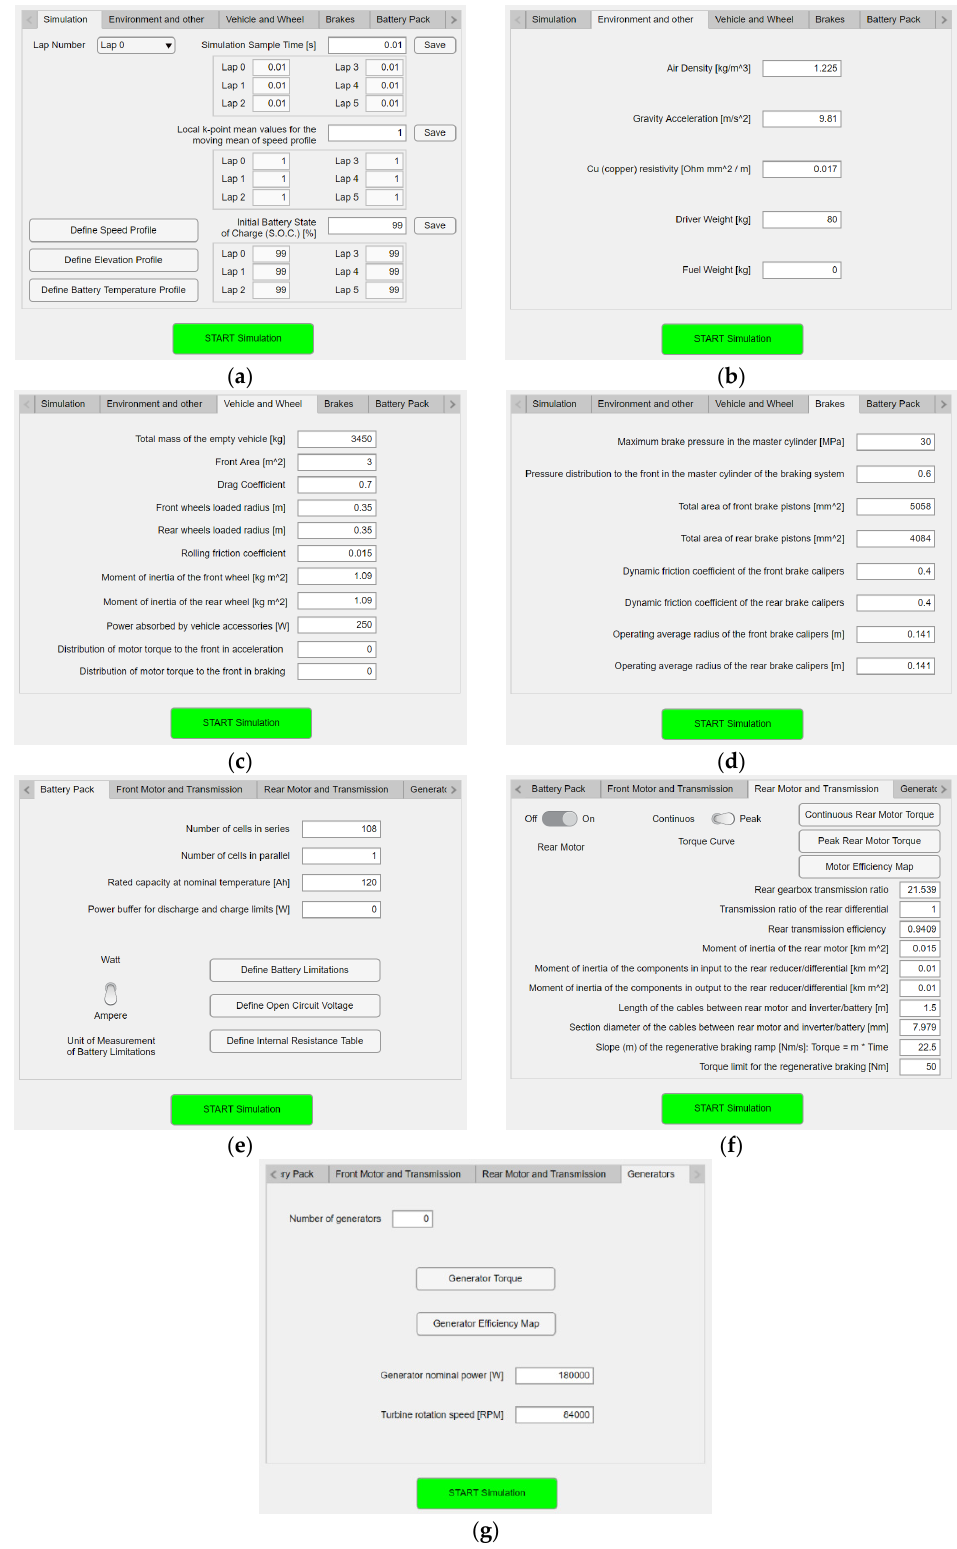
Figure 4. Different panels of the Graphic User Interface. In particular, the panels allow you to enter the inputs regarding: ( a ) The simulation parameters; ( b ) Environmental and other parameters; ( c ) Vehicle and Wheels parameters; ( d ) Brakes parameters; ( e ) Battery Pack parameters; ( f ) Motor and Transmission parameters; ( g ) Generators parameters.